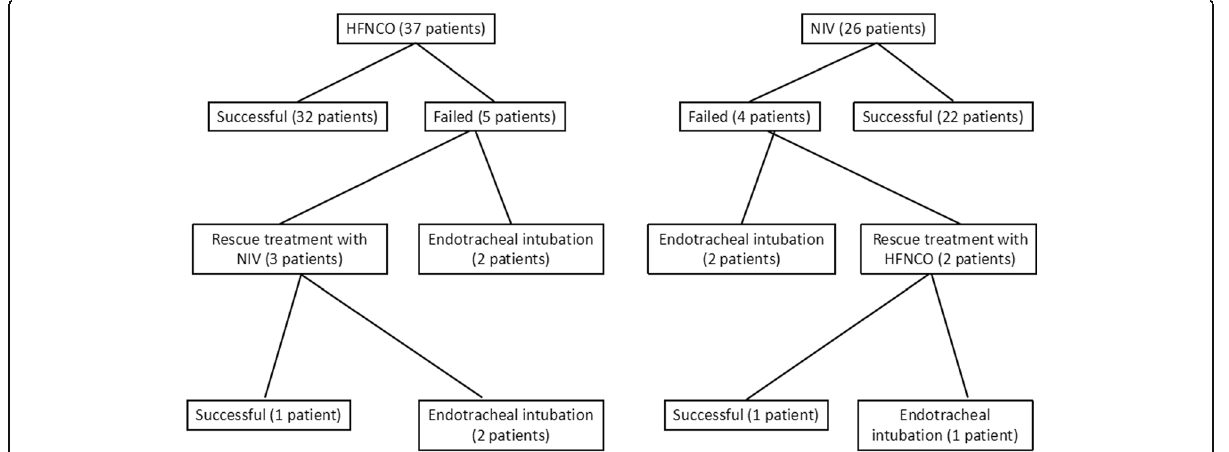
Fig. 1 Flow chart for the outcomes of patients receiving HFNCO and